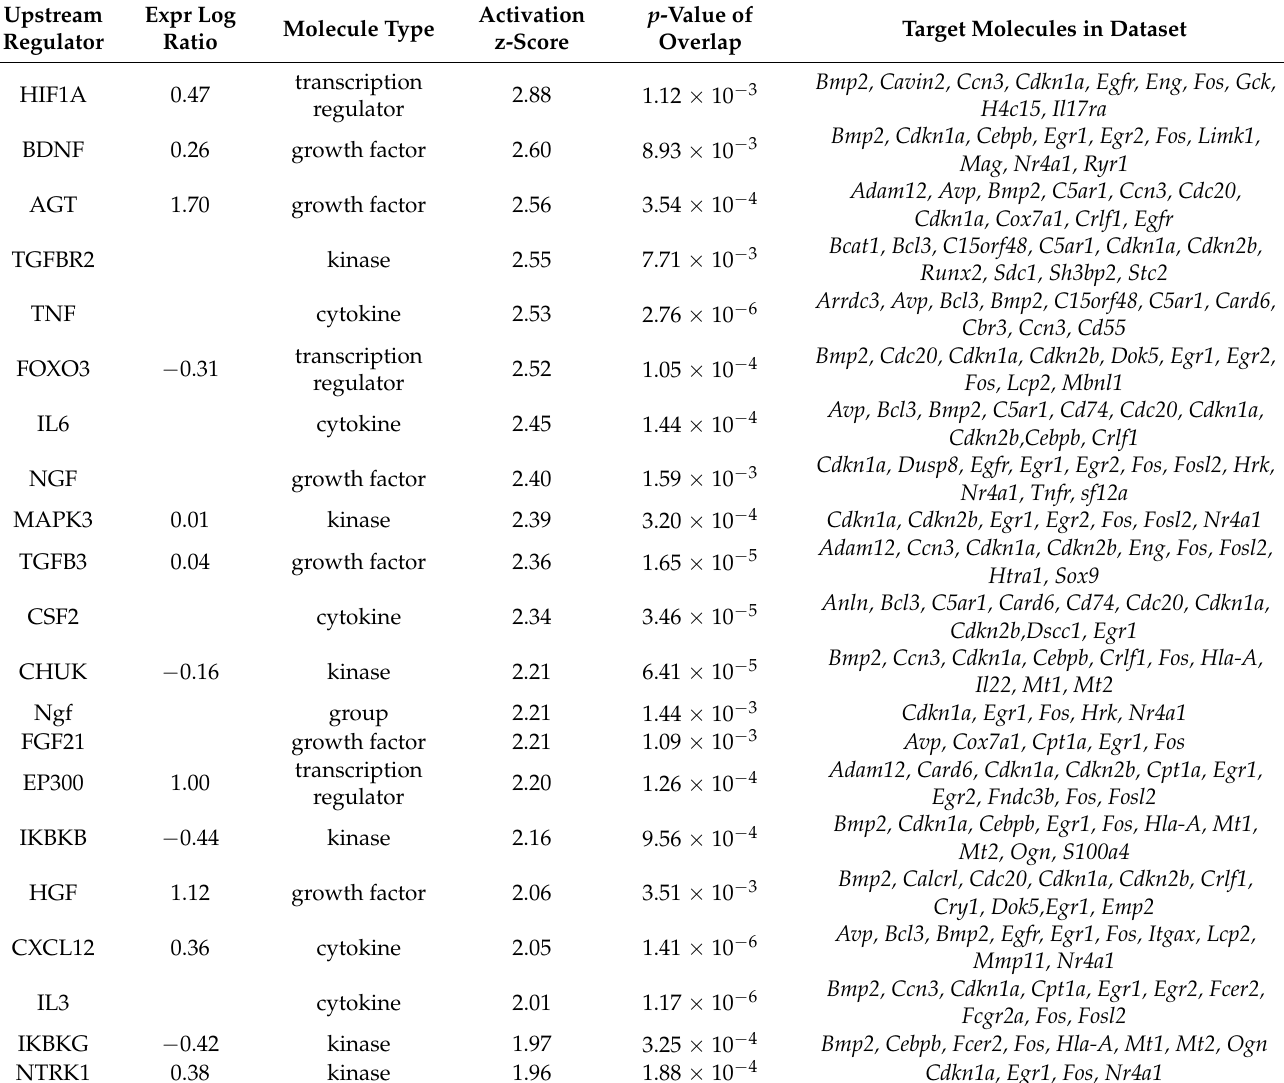
Table 3. Upstream regulators identified as significantly activated in the “OHT + DREADD” RGCs